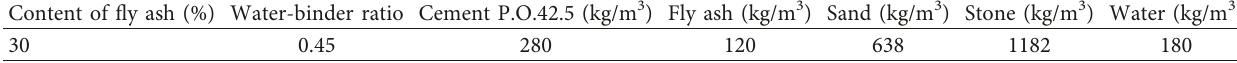
Table 1: Concrete mix design.